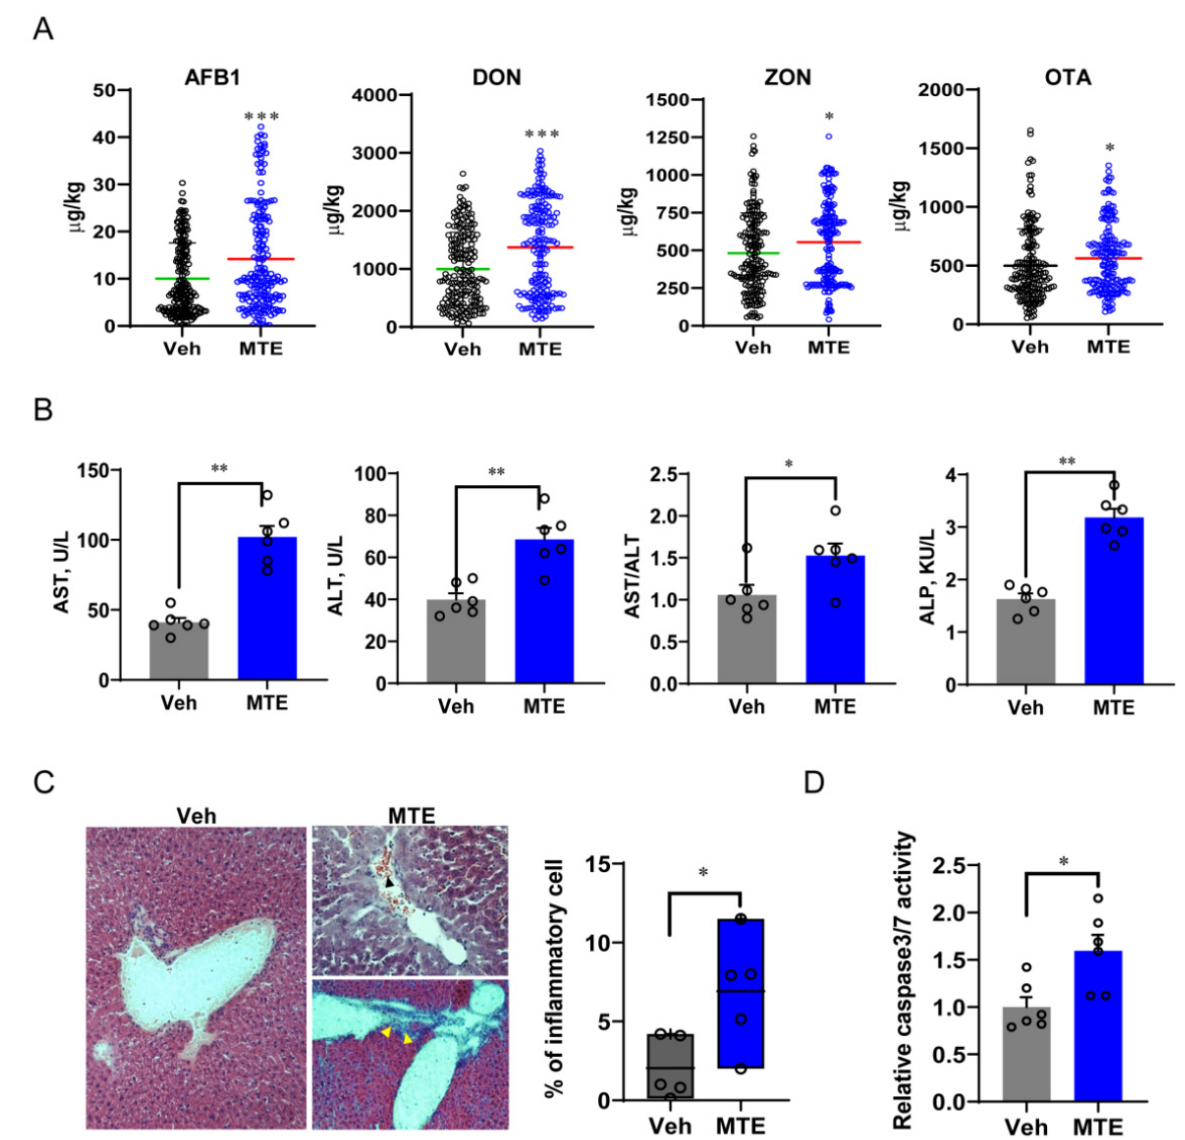
Figure 1. Mycotoxin exposure is associated with liver injury in piglets. ( A ) Feed samples were collected and used to measure the content of mycotoxins by the competitive enzyme immunoassay using the kits from R-Biopharm AG. ( B ) Blood AST (aspartate transaminase), ALT (alanine aminotransferase), and ALP (alkaline phosphatase) concentrations, and the AST/ALT ratio. ( C ) Representative images of liver sections stained with hematoxylin and eosin from the Veh and MTE groups, respectively. The upper right panel shows diffused cell infiltration and blood cell accumulation (black arrow). Yellow arrows (bottom right panel) point to mononuclear cell infiltration at the portal area. ( D ) Analysis of the percentage of inflammatory cells ( n = 5); hepatocyte apoptosis is reflected by activation of caspase 3/7. The data are shown as the means ± SEM, n = 6, * p < 0.05, ** p < 0.01, *** p < 0.001, using ANOVA with Tukey’s post hoc test.